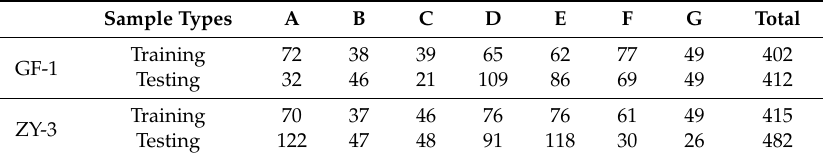
Table 3. Training and testing sample size for GF-1 and